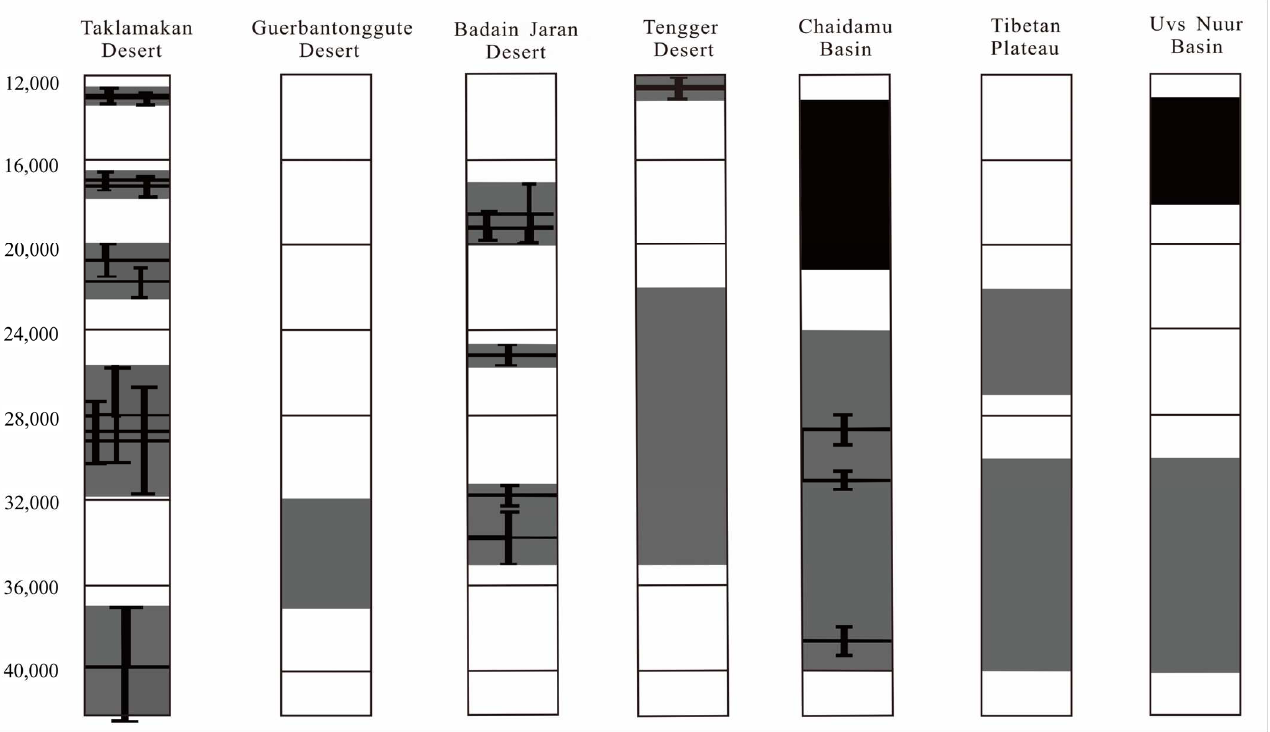
Figure 6. Histogram of Pleistocene wetter epochs (gray, the solid lines indicating ages with error bars) and distinct drier periods (black) recognized in the sandy deserts of northern China in a west–east transect (modified after [61]).